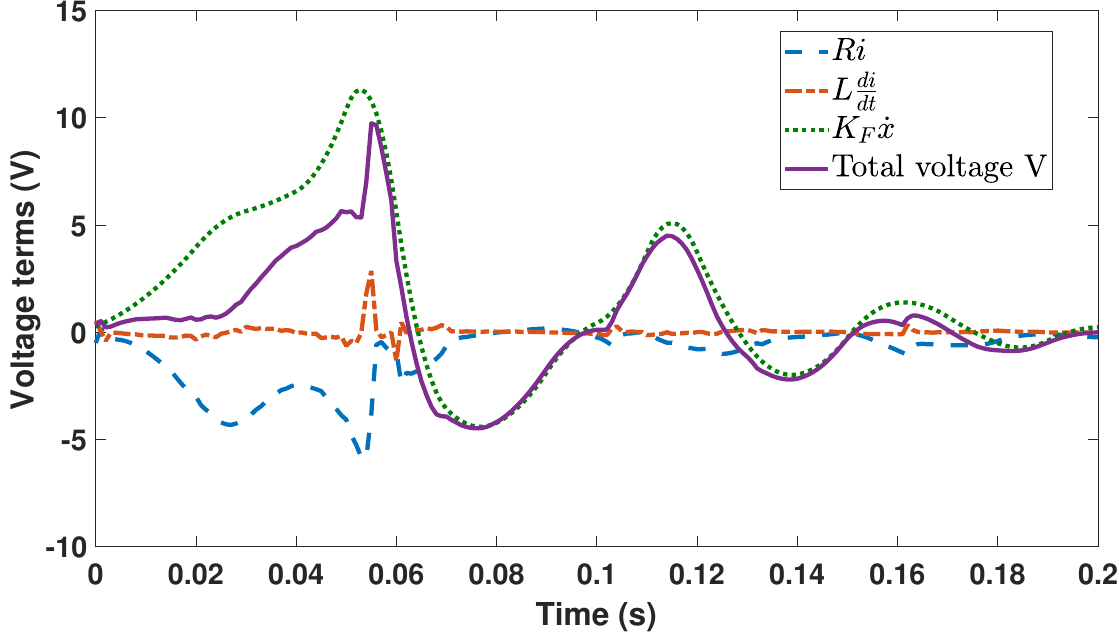
Figure 12. Voltage decomposition according to (4) for the soft force